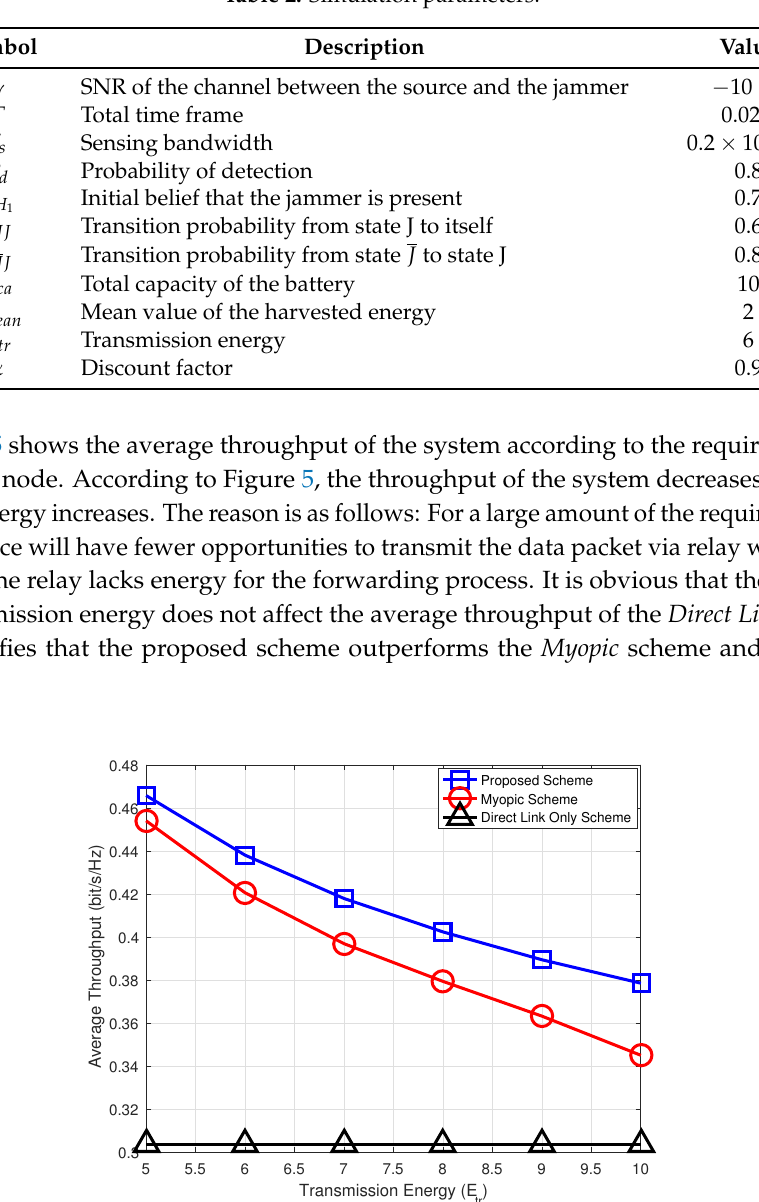
Table 2. Simulation parameters.